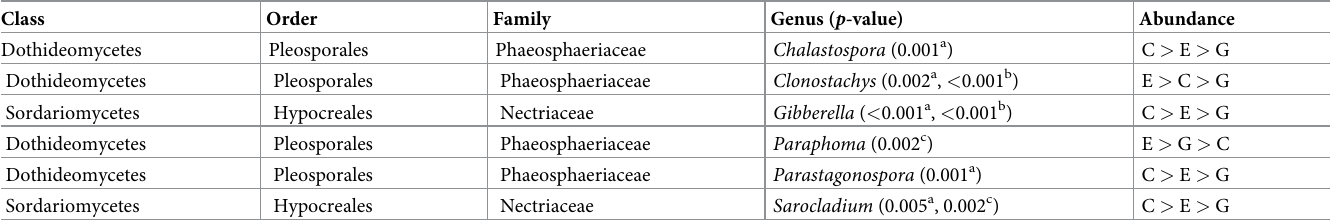
Table 1. Fungal genera abundance across croplands and perennial